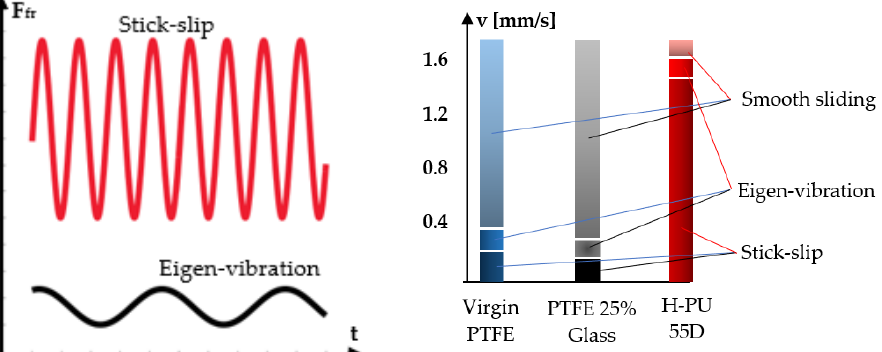
Figure 11. Critical velocity values for the onset of stick-slip and eigen-vibrations by seal material.